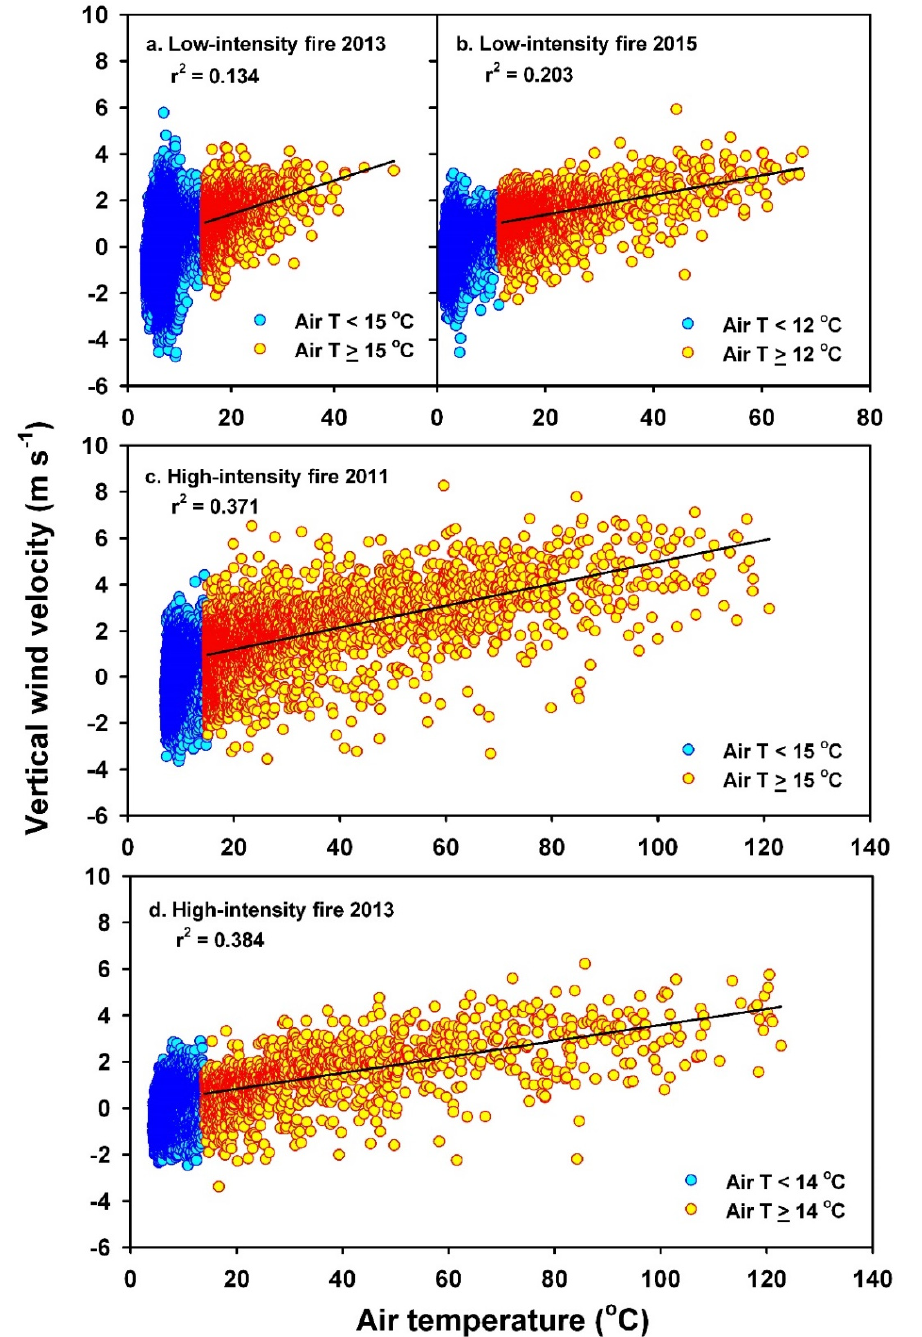
Figure B1. The relationship between sonic air temperature and vertical wind velocity measured above canopy at 10 Hz for ( a ) a low-intensity backing fire in a pitch pine–scrub oak stand at Cedar Bridge in 2013, ( b ) a low-intensity fire in a pitch pine–scrub oak stand near Warren Grove in 2015, ( c ) a high-intensity fire in a pine–oak stand at Butler Place in 2011, and ( d ) a high-intensity head fire in a pitch pine–scrub oak stand near Warren Grove in 2013. Yellow symbols indicate values ≥ 5 °C above ambient air temperature measured above canopy on control towers. Sampling duration and statistics for Pearson’s product moment correlation coefficients for all eight prescribed fires are shown in Table B3. Table B3. Linear models of air temperature and vertical wind velocity measured at 10 Hz on burn area towers during the eight prescribed fires when air temperature was ≥ 5 °C above ambient air temperature measured on control towers shown in Figure B1. Values are air temperature at ≥ 5 °C above ambient air temperature, number of 10 Hz values ≥ 5 °C above ambient air temperature when